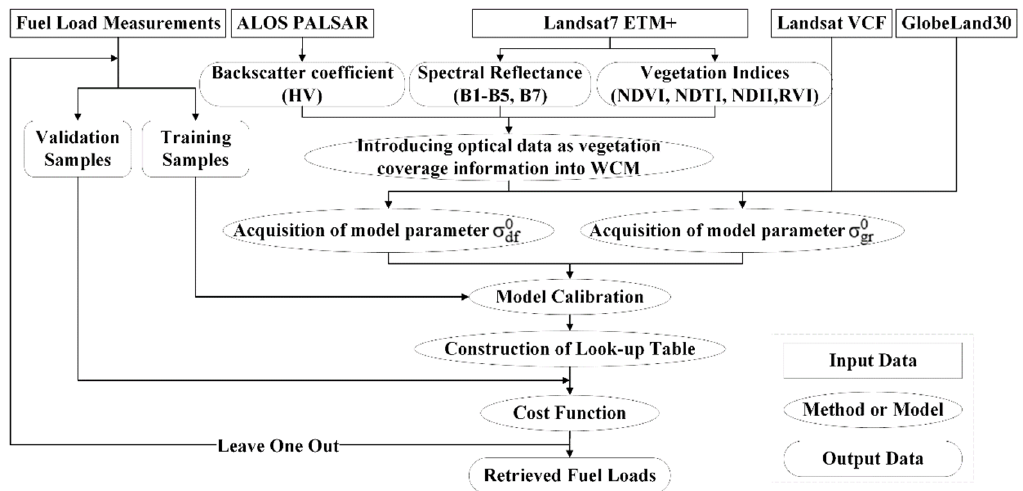
Figure 2. Methodological flowchart of FL AG estimation from integrated optical and SAR data with new model.